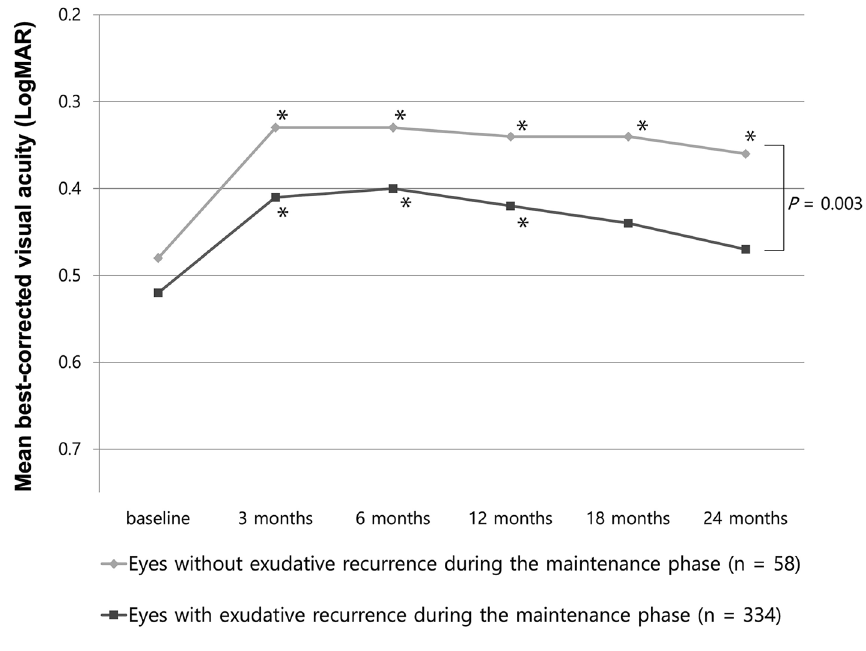
Figure 1. Mean best-corrected visual acuity (BCVA) of the groups with and without exudative recurrence during the 24-month follow-up. The improved visual acuity after three loading injections was maintained in the eyes without exudative recurrence during the 24 months, whereas that of the eyes with exudative recurrence showed a gradual decline (* P < 0.05, compared with baseline BCVA). At 24 months, the eyes without exudative recurrence showed significantly improved BCVA than those having exudative recurrence more than once ( P =